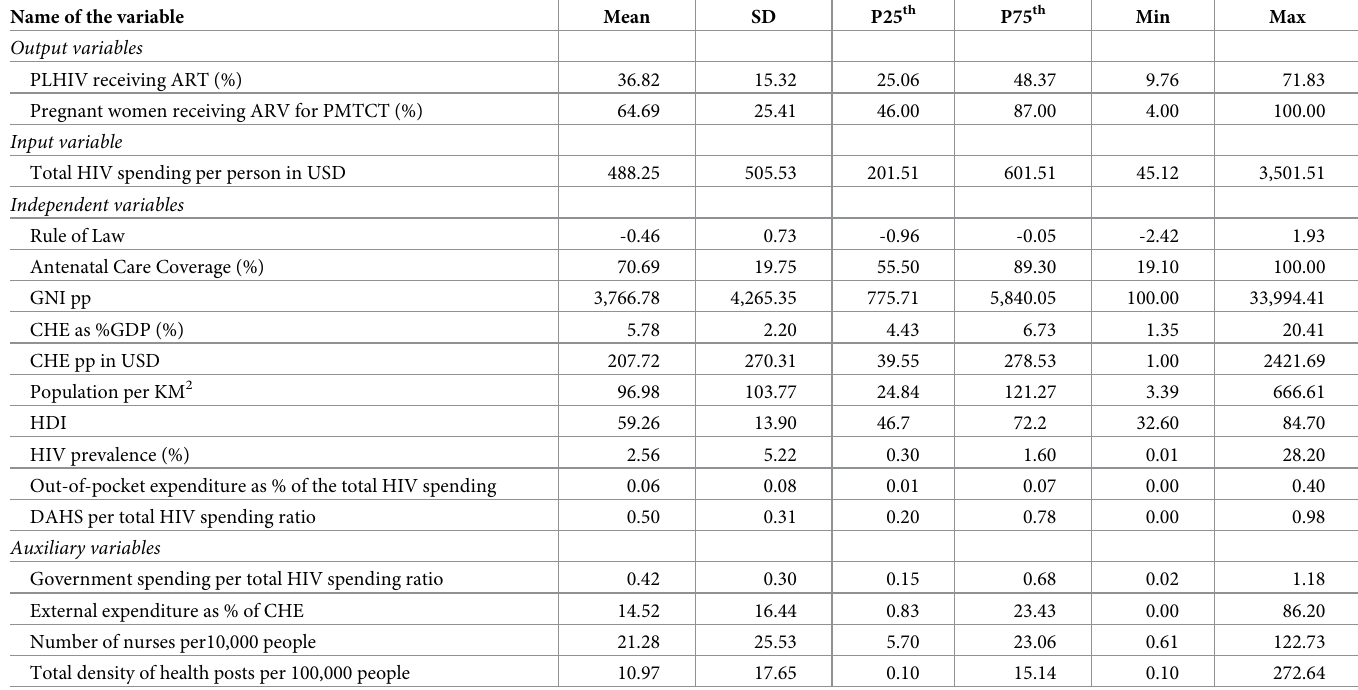
Table 3. Descriptive statistics and imputed missing data final sample (N = 78